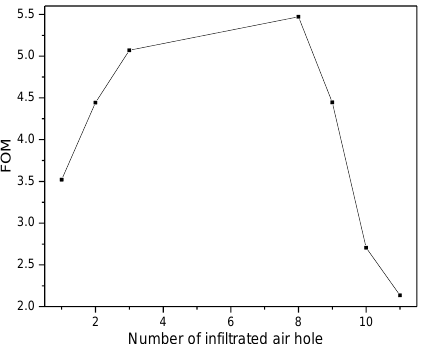
Figure 7. Figure of merit (FOM) of the infiltrated structure as a function of the number of infiltraed air holes.